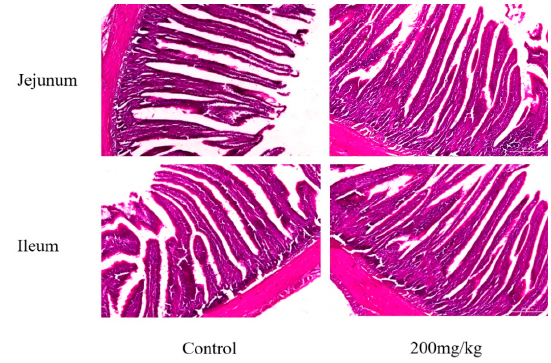
Figure 1. Light micrograph of HE staining showing difference in length of the intestinal villi and